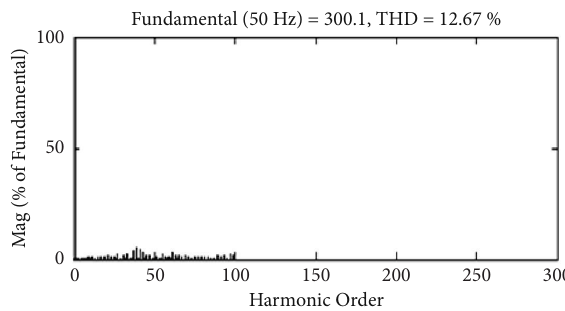
Figure 16: Voltage THD waveform.